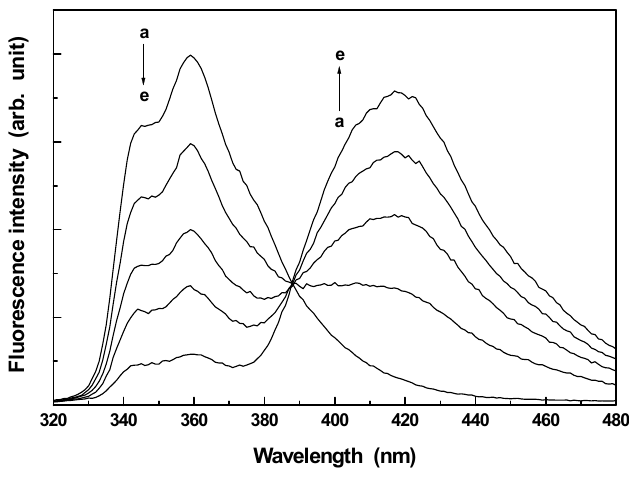
Figure 1. Fluorescence spectra of CAZL in presence of different concentrations of NaOH. a → e corresponds to 0.0, 0.005, 0.01, 0.02 and 0.06M NaOH respectively. The excitation wavelength is 295